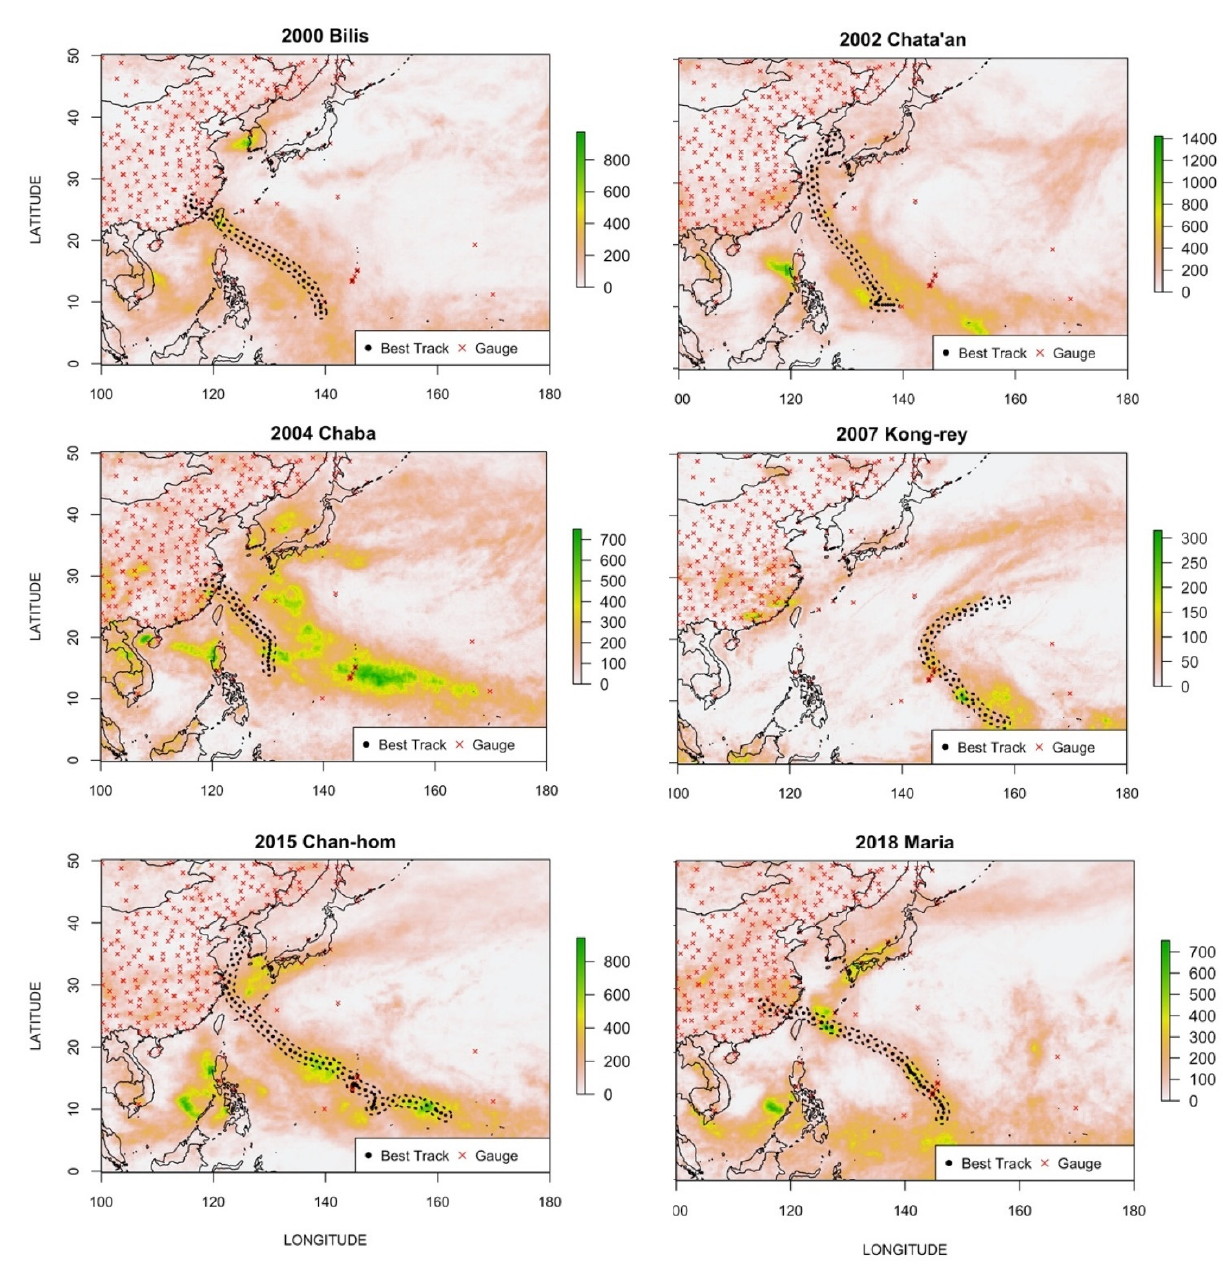
Figure 2. Cumulative precipitation maps of six of the storms analyzed showing best track locations and all gauges in the map.